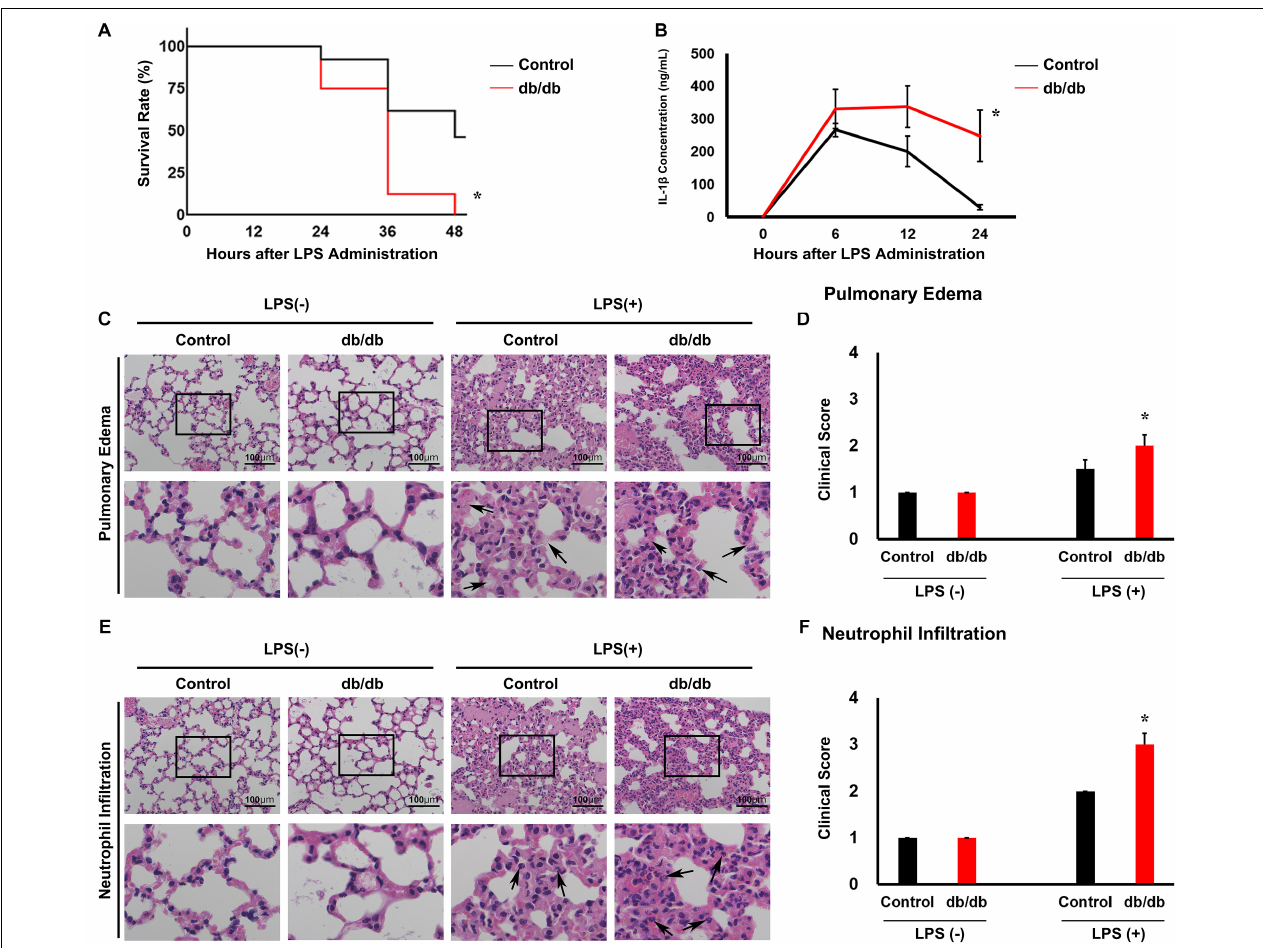
FIGURE 2 | Lipopolysaccharide (LPS)-induced lung injury is accelerated in db/db mice compared with in control mice. (A) Kaplan–Meier survival curves for control mice ( n = 24) and LPS-treated mice ( n = 10). (B) Serum interleukin 1 β (IL-1 β ) was measured in mice using an enzyme-linked immunosorbent assay. (C) Hematoxylin and eosin-stained lung tissues. Arrows indicate neutrophil infiltration. (D) Graphs of the histologic scoring of lung injury around the pulmonary edema. (E) Hematoxylin and eosin-stained lung tissues. (F) Arrows indicate edema. Graphs of the histologic scoring of lung injury around neutrophil filtration. n = 6 mice per group. *, P <